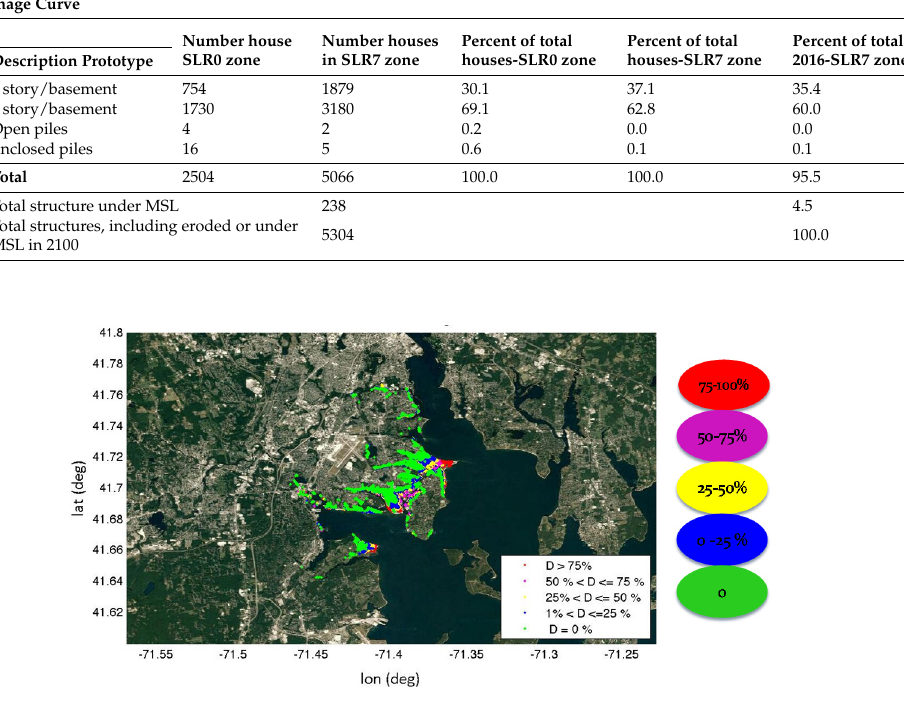
Figure 17. Percent damage by structure for Warwick, RI for 100 year event.